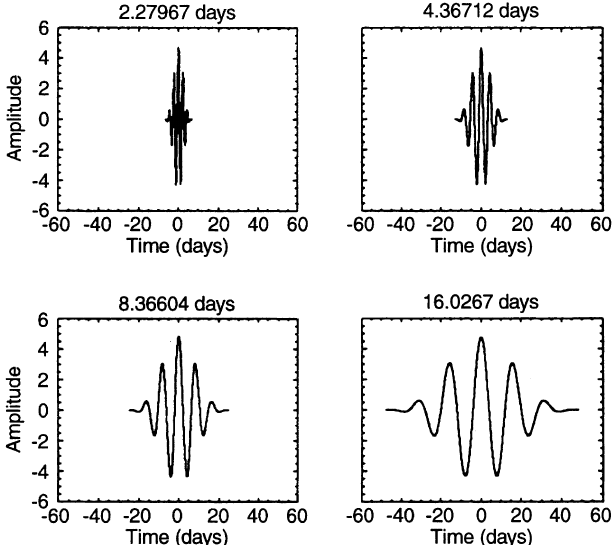
Fig. 6. The time domain filter coe(cid:129)cients for 4 filter bands from the constant- Q filter bank shown in